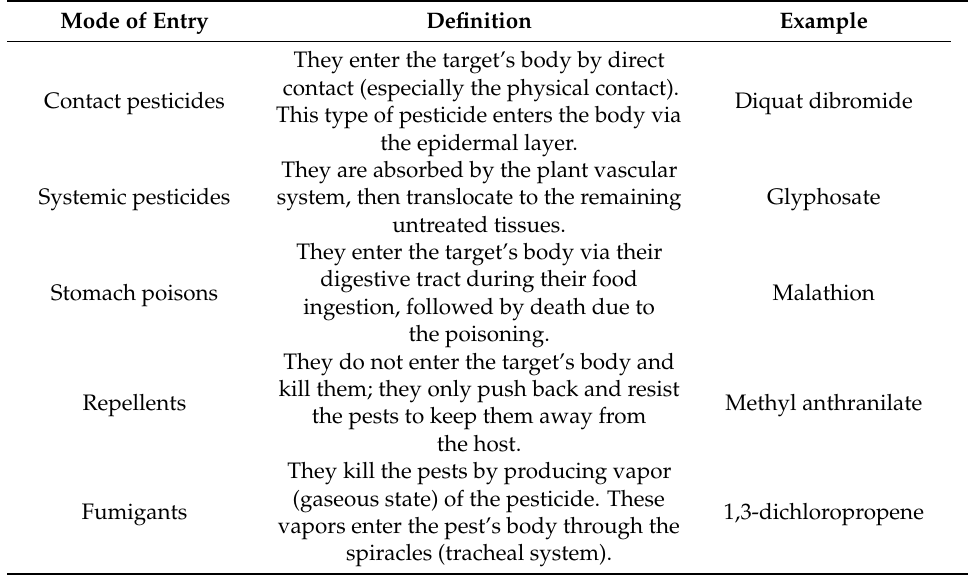
Table 3. Pesticides classification according to the mode of entry (Modified from Yadav and Devi